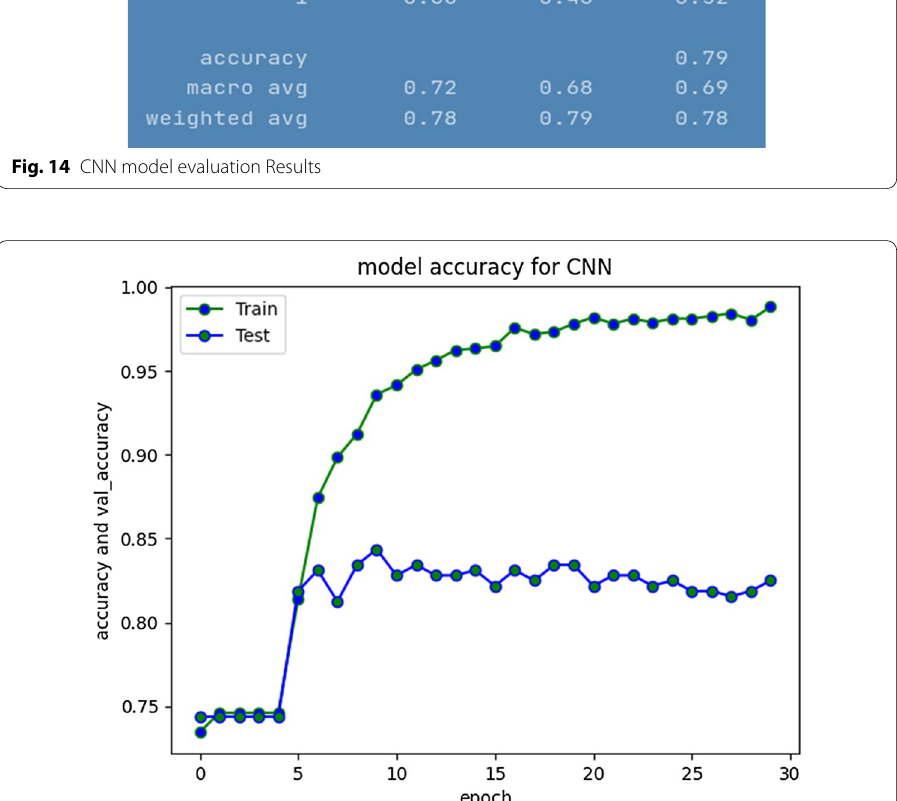
Fig. 15 CNN Model accuracy plot for 30